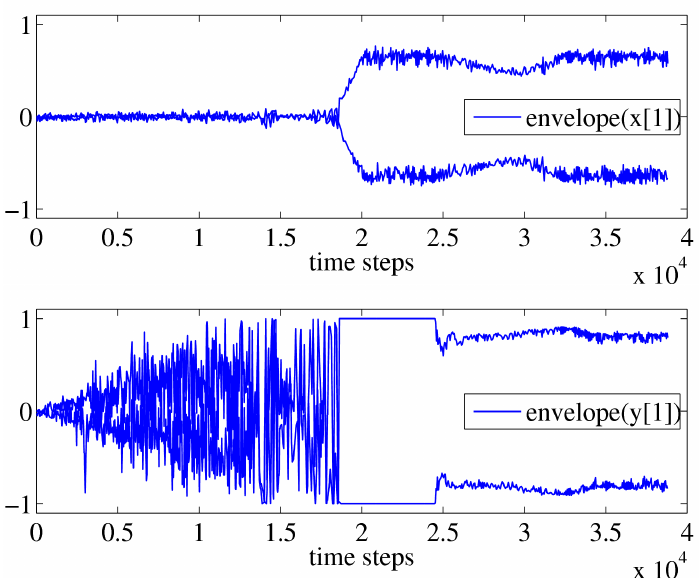
and motor value y during the experiment. The 1 1 fluctuates around zero at the 1 also fluctuates around zero in the beginning, but 1 and y look 2 2